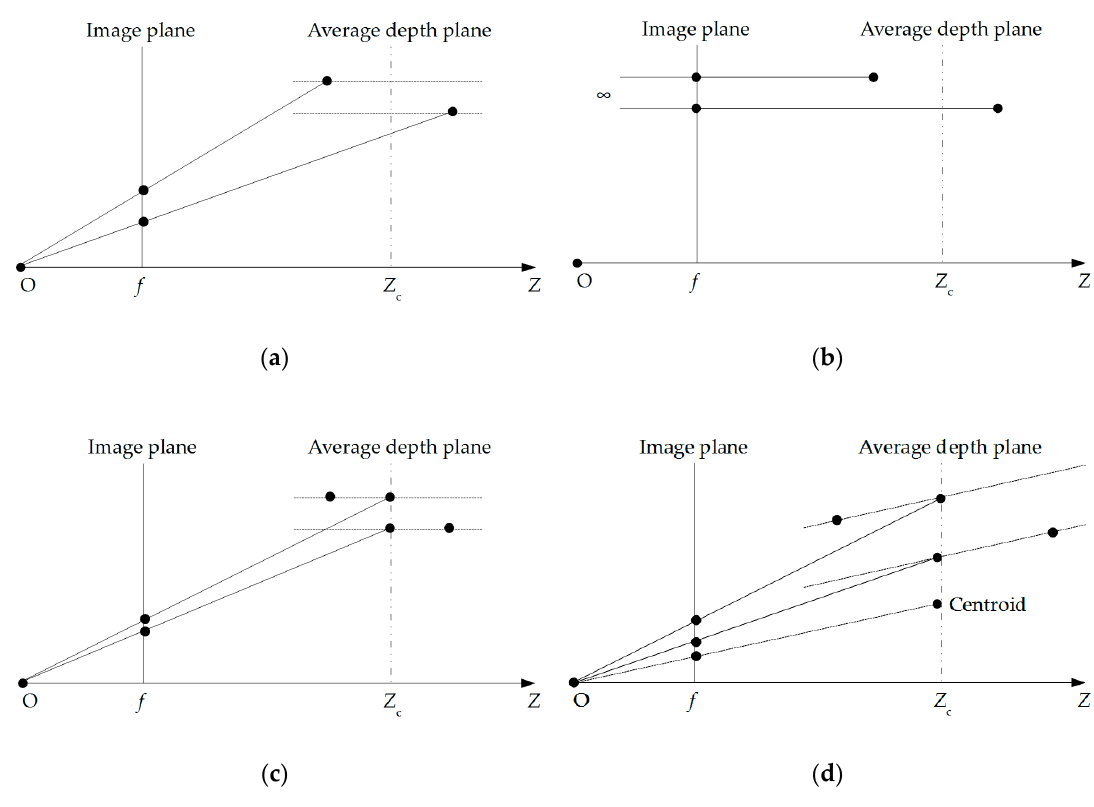
Figure 3. Geometrical camera models: ( a ) perspective; ( b ) orthographic; ( c ) weak perspective; ( d ) paraperspective (adapted from reference [6]).